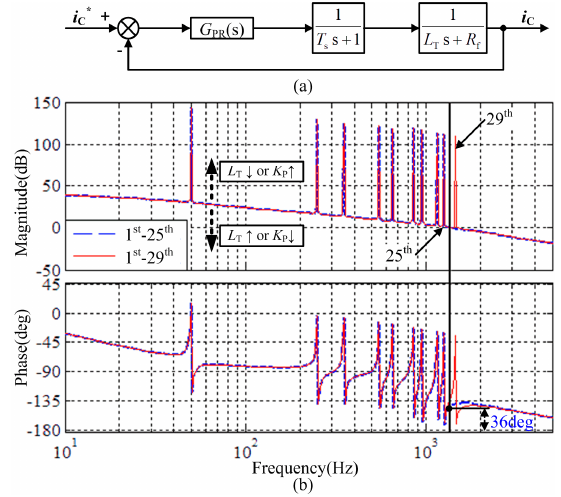
Figure 4. Current control model and open-loop Bode plots. ( a ) Current control model; and ( b ) open- loop Bode plots.